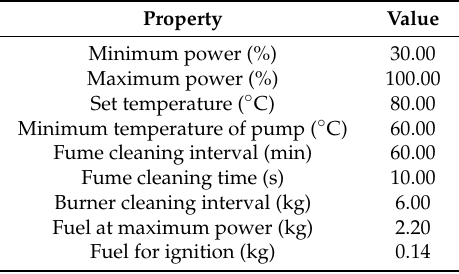
Table 2. Variables of boiler operation.